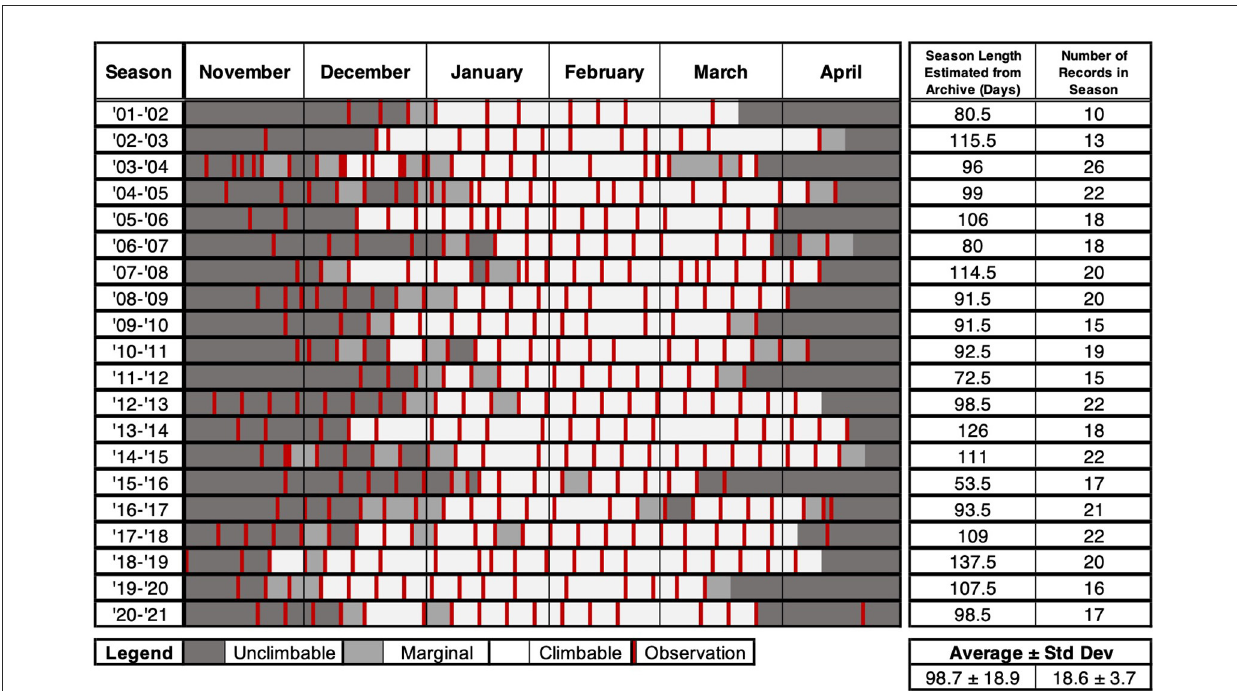
FIGURE3 The map of quality across the 20-year archive record shows season length and quality vary annually. While each year did not have a consistent number of records, in most years roughly weekly reporting from December through late March captured ice quality observations through the season. The archive captures some novel behavior in recent years. While January thaws occurred through the period of record, significant February thaws only occurred in 2015/2016 and 2016/2017.